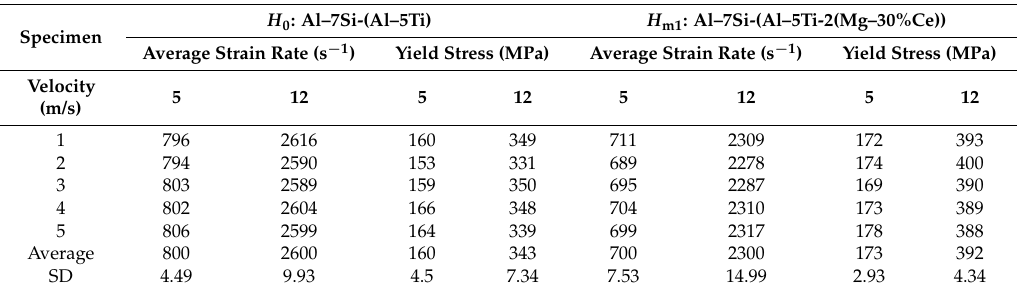
Table 3. SHPB experimental data of